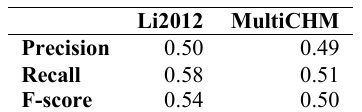
Table 2. Detection scores weighted with volume.